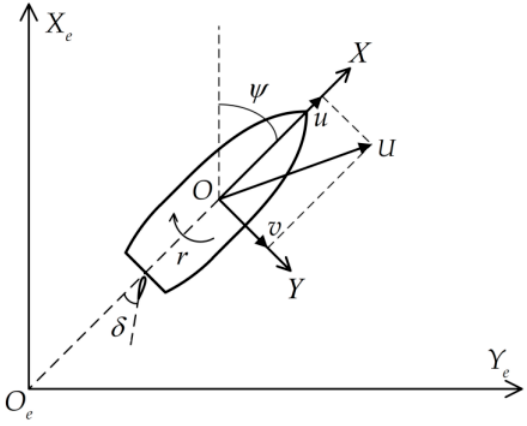
Figure 1. Coordinate